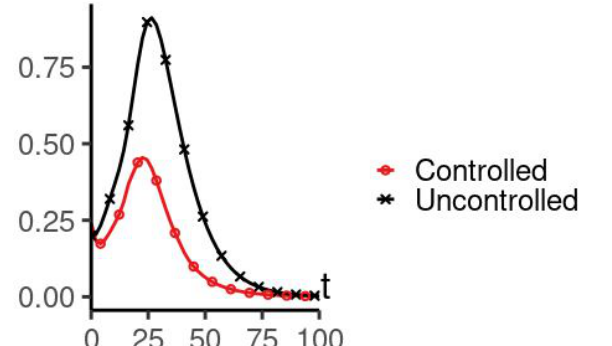
Figure 25. Experiment 4. Aggregation costs in uncontrolled and controlled cases with irresponsi- ble